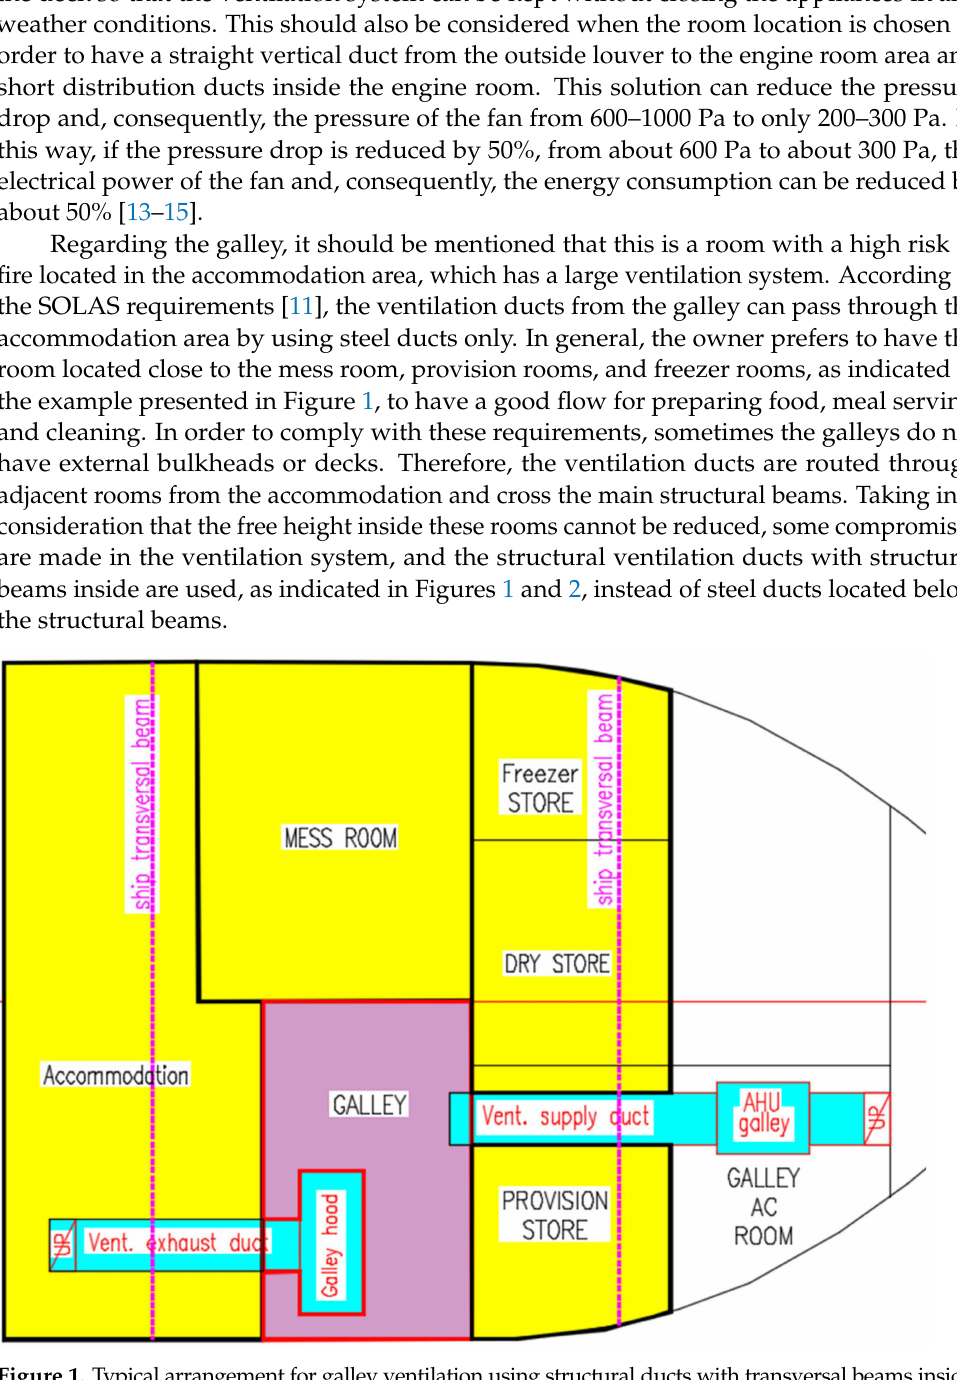
Figure 1. Typical arrangement for galley ventilation using structural ducts with transversal beams